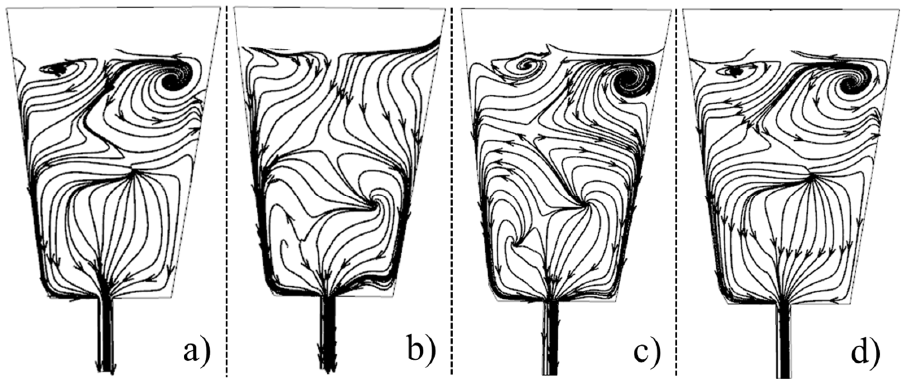
Figure 5. Streamline at plane 2 under different heating powers. ( a ) Without plasma heating, ( b ) 300 kW, ( c ) 500 kW and ( d ) 1000 kW.